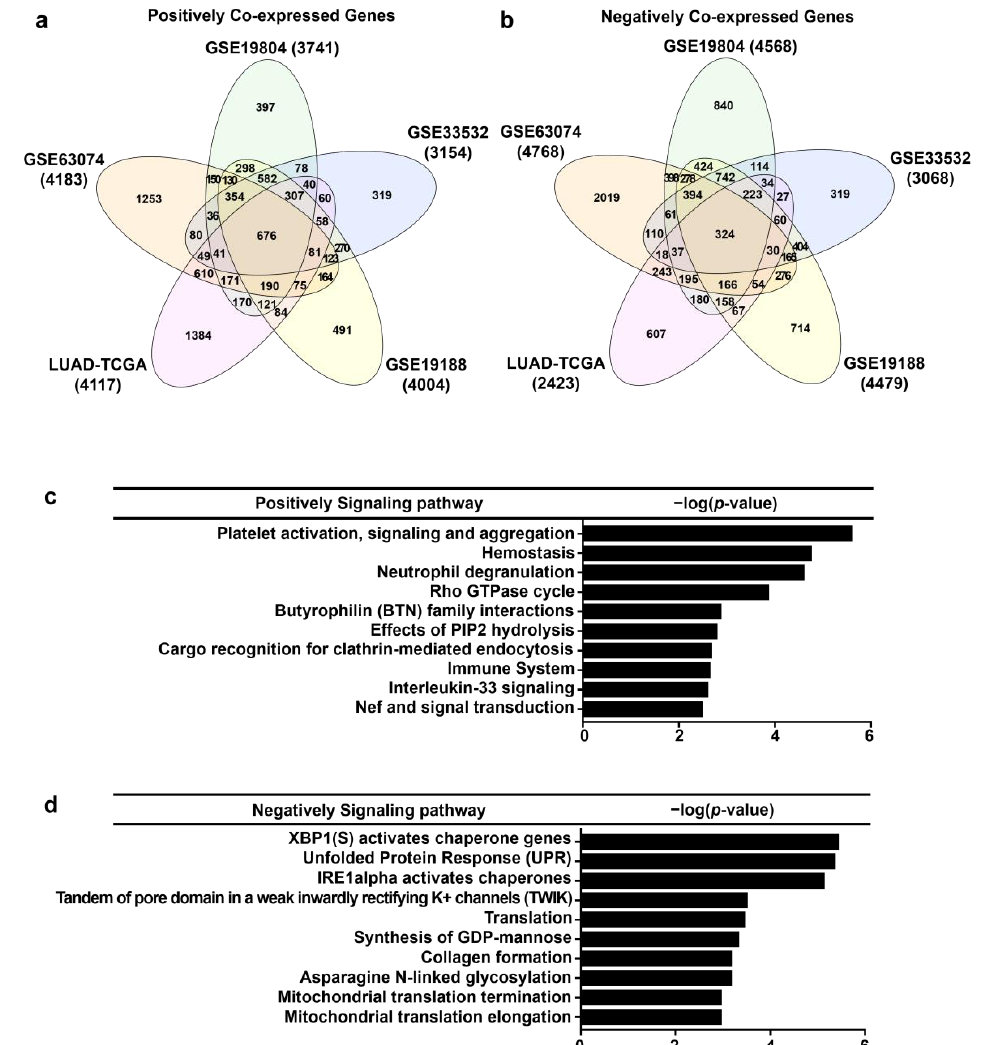
Figure 6. Positively and negatively correlated genes and signaling pathways in five public